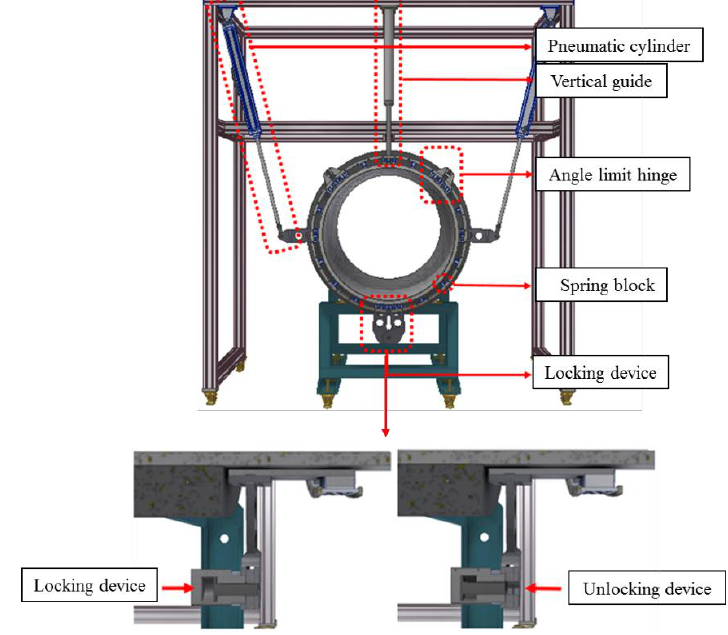
Figure 11. Description of the welding guide track system.